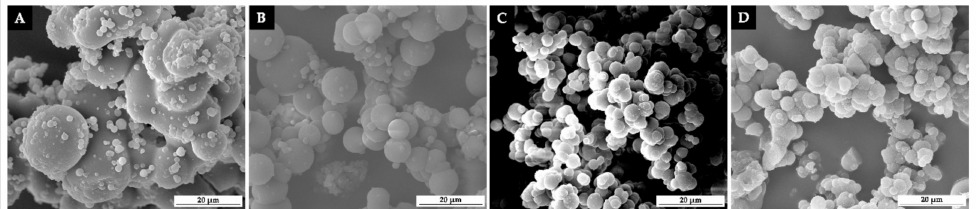
Figure 2. The SEM morphology of microcapsules prepared at different stirring rates: ( A ) 400 rpm, ( B ) 600 rpm, ( C ) 800 rpm, ( D ) 1000 rpm.